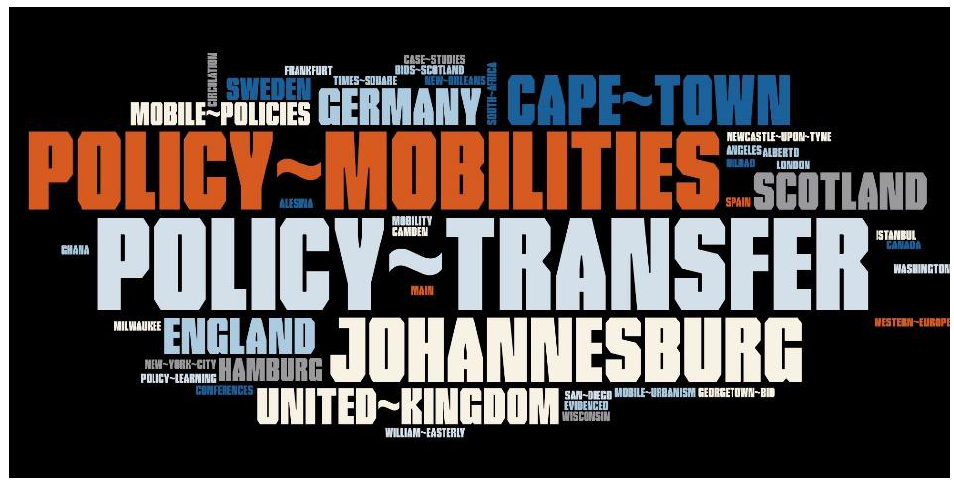
Figure 6. Word cloud, extracted from keywords that fit in dimension “Urban policies: mobility and transfer”.